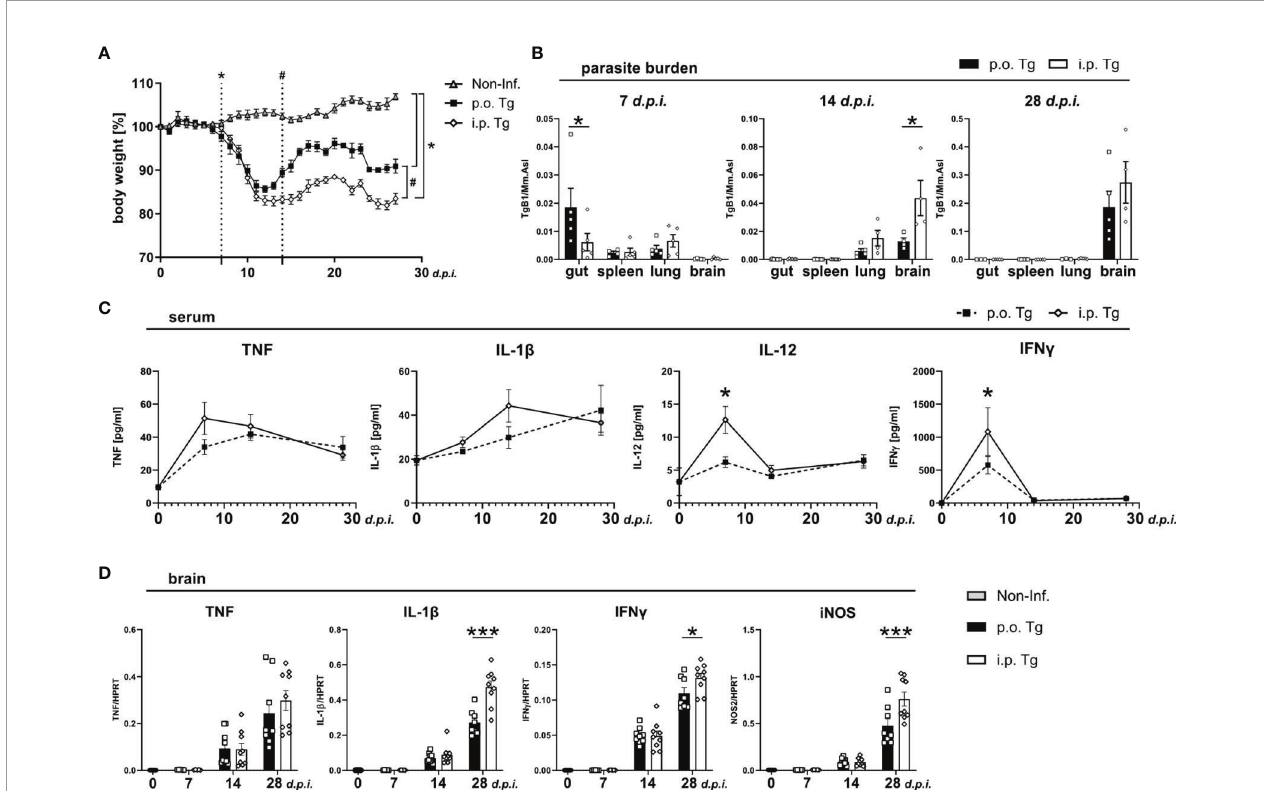
FIGURE 1 | Increased weight loss, parasite spread, and immune response in i.p. T. gondii infected mice. Wild-type mice were infected orally ( p.o. Tg) or intraperitoneally ( i.p. Tg) with T. gondii (two cyst, ME49) and (A) weighed daily. Differences between non-infected (Non-Inf.) and T. gondii infected animals (indicated by *, signi fi cant from 7 days post-infection as well as p.o. and i.p. infected animals (indicated by #; signi fi cant from day 14 p.i. ) were analyzed. (B) Parasite burden was analyzed in the ileum (gut), spleen, lung, and brain of p.o. and i.p. infected animals. (C) Levels if indicated cytokines were determined in sera f naïve mice (d0) and T. gondii infected animals (7, 14, and 28 d .p.i. ) mice. (D) mRNA levels of indicated genes were determined in the brain. Data are presented as mean ± SEM. Differences between groups were analyzed by two-way ANOVA followed by Tukey ’ s multiple comparisons test (*p<0.05,